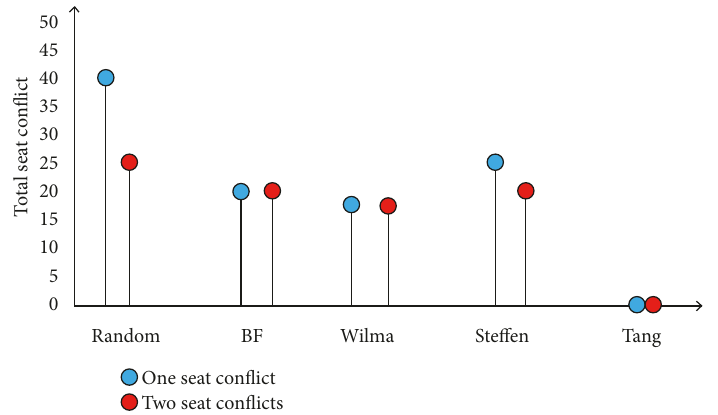
Figure 6: The number of seat conflicts under the random, BF, Wilma, Steffen, and proposed